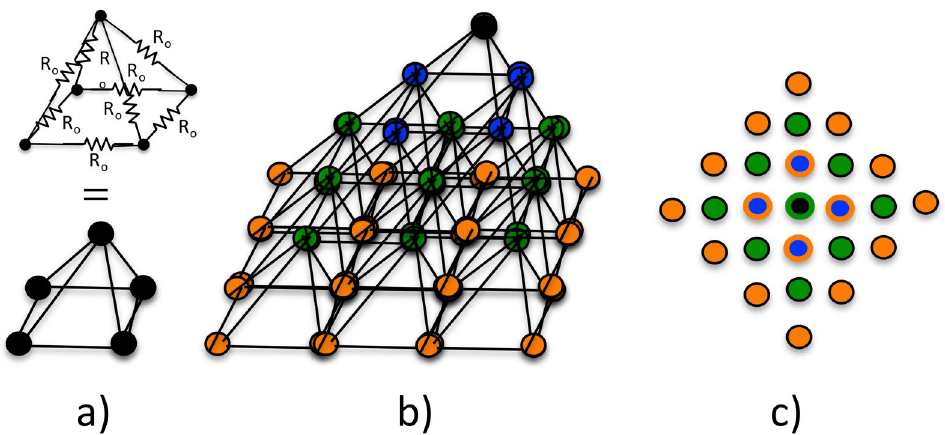
Figure 6. ( a ) Every Cu atom is connected to four Cu atoms in the next subjacent layer. Each connection between the Cu atoms corresponds to a unit resistance of R o = 1/G o . ( b ) Pyramidal 3D resistor network with one atom at the top and three subjacent layers shown. ( c ) Projection of the pyramid onto the plane of the base of the pyramid. The first layer consists of one atom (black) the 4th layer consists of 16 atoms (orange). In general, nth layer consists of n 2